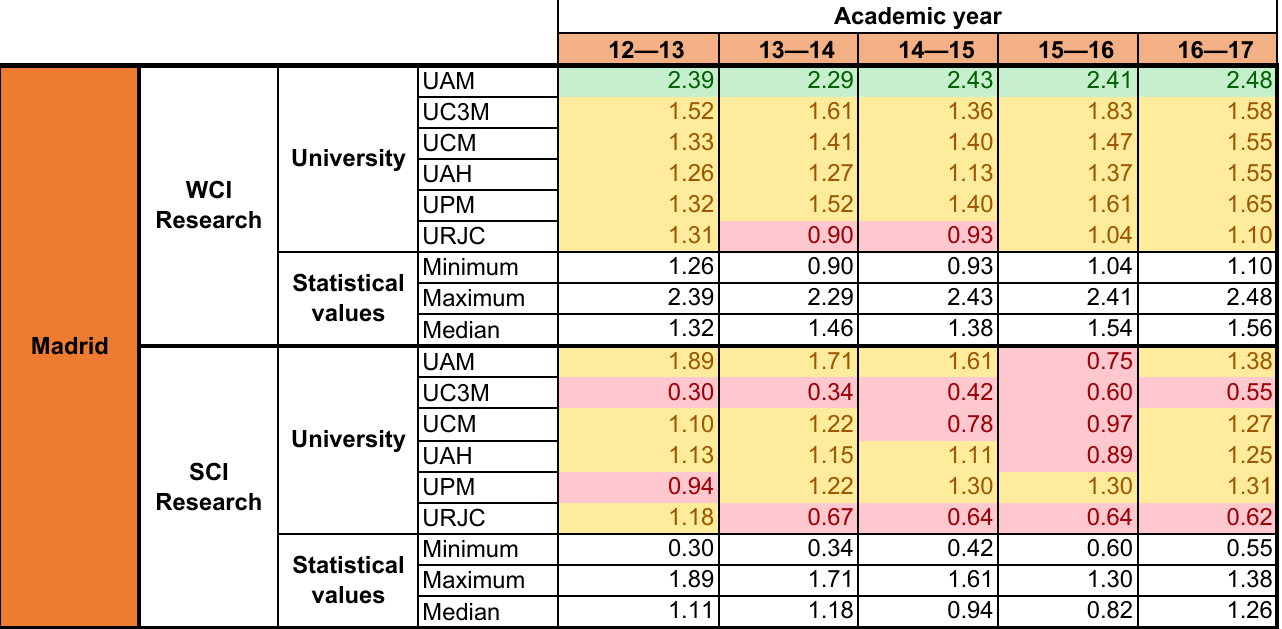
Figure A10. WCI and SCI values of the Catalan public universities in their research mission.